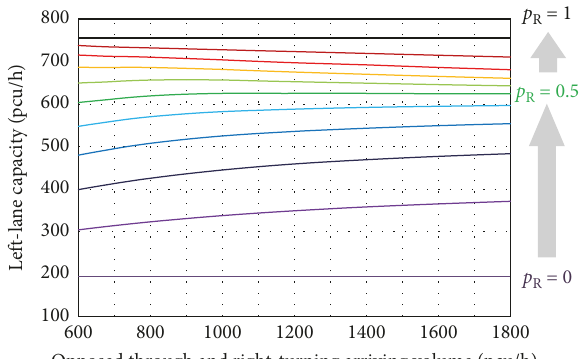
Figure 8: Sensitivity of left-lane capacity to opposed arriving volume and the rate of right turns p R .